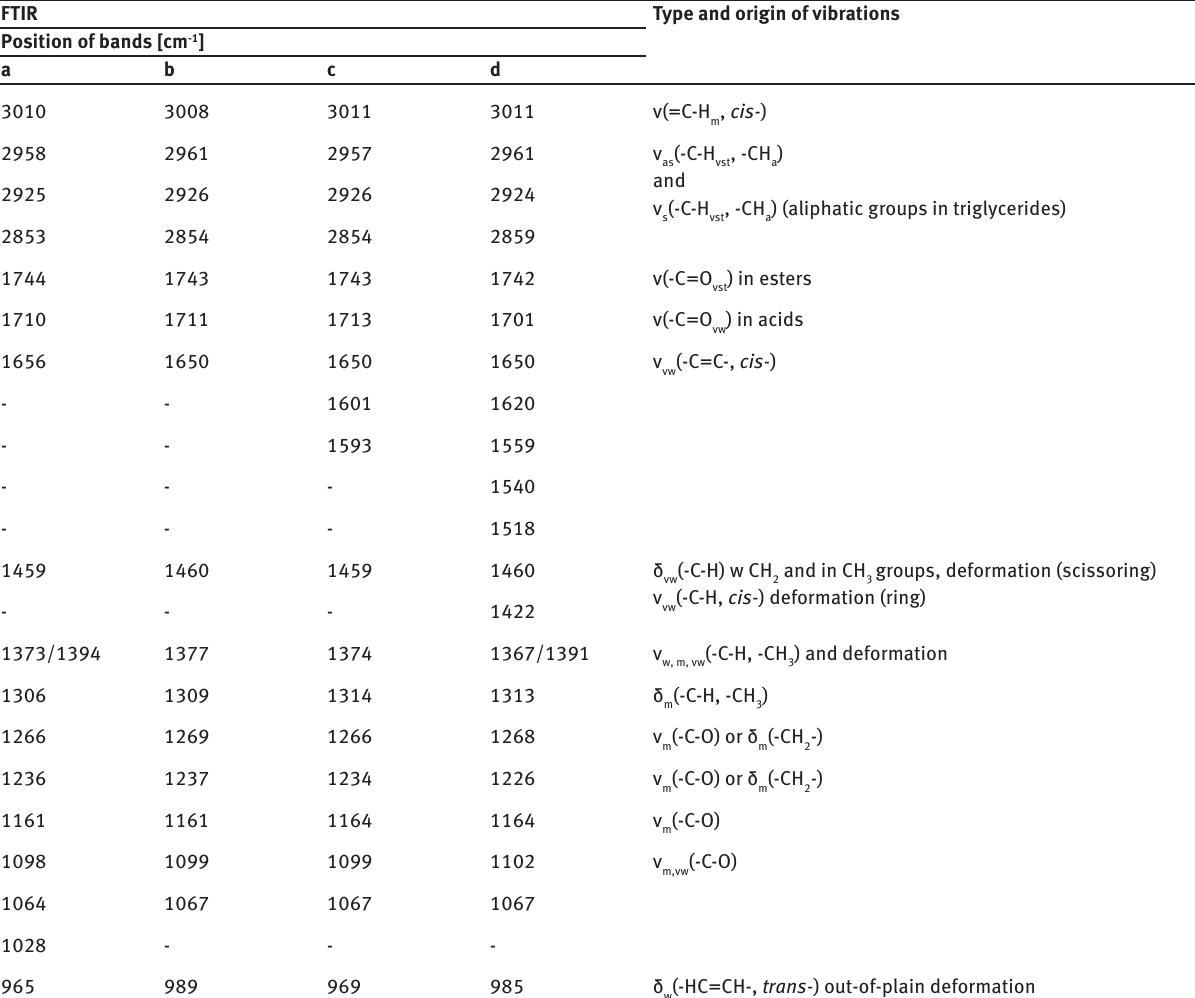
Table 1: Positions of the maxima of absorption spectra and assignment to the relevant vibrations recorded for Moldavian dragonhead oil samples stored at 7 o C (refrigerated), a – immediately after pressing, b – two weeks after pressing, c – four weeks after pressing and d – 8 weeks after